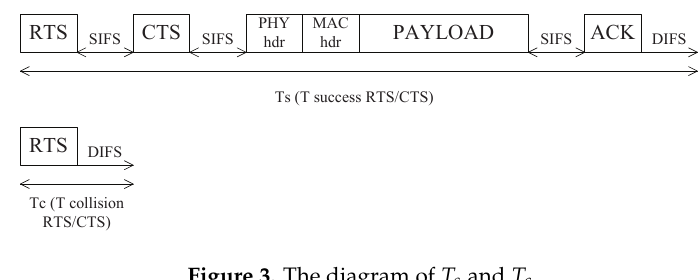
Figure 3. The diagram of T s and T c